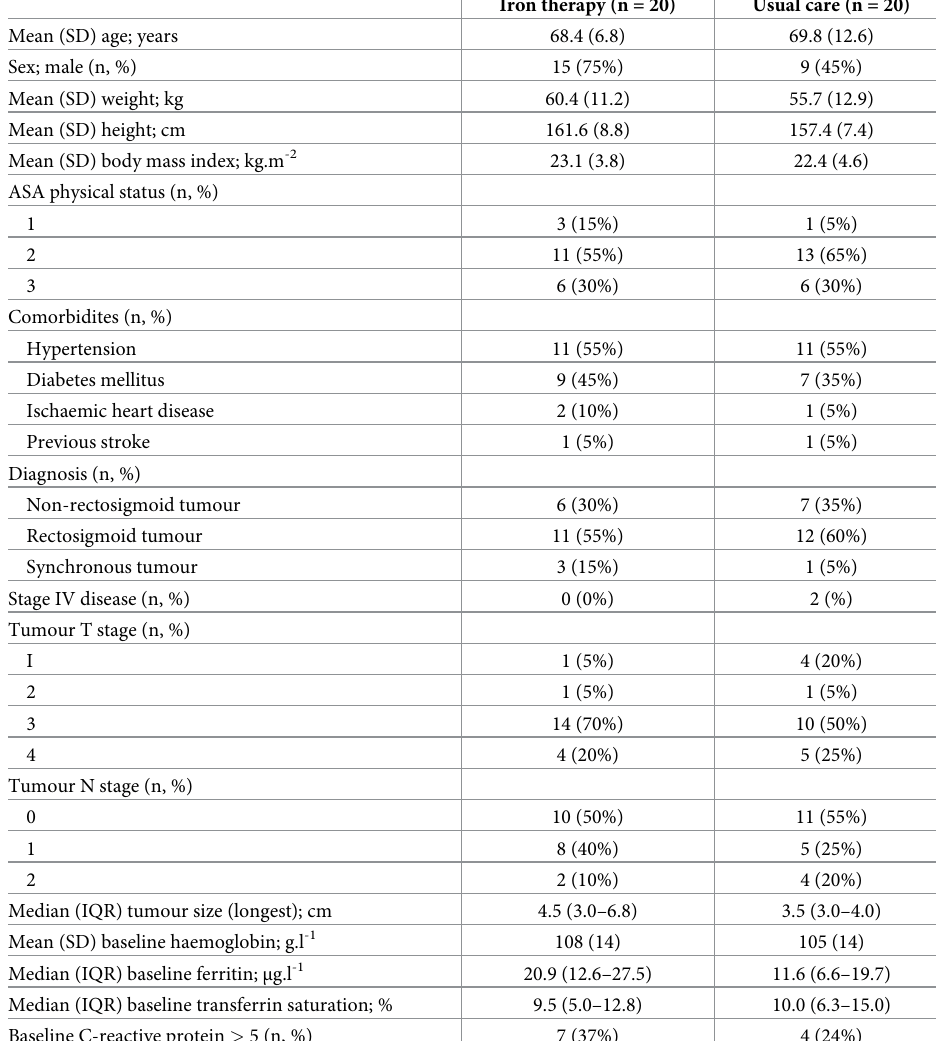
Table 1. Characteristics and preoperative data of patients receiving iron isomaltosides or usual